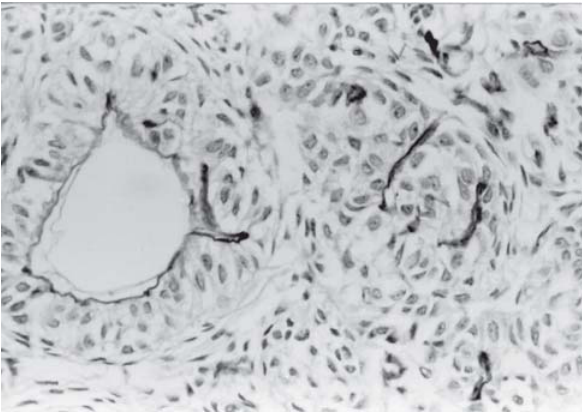
FIGURE 4- Reduced enamel epithelium: All cells exhibiting CK14. X400